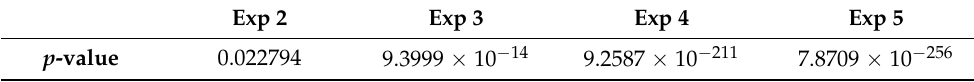
Table 4. LSTM-RNN models’ lowest errors statistical significance